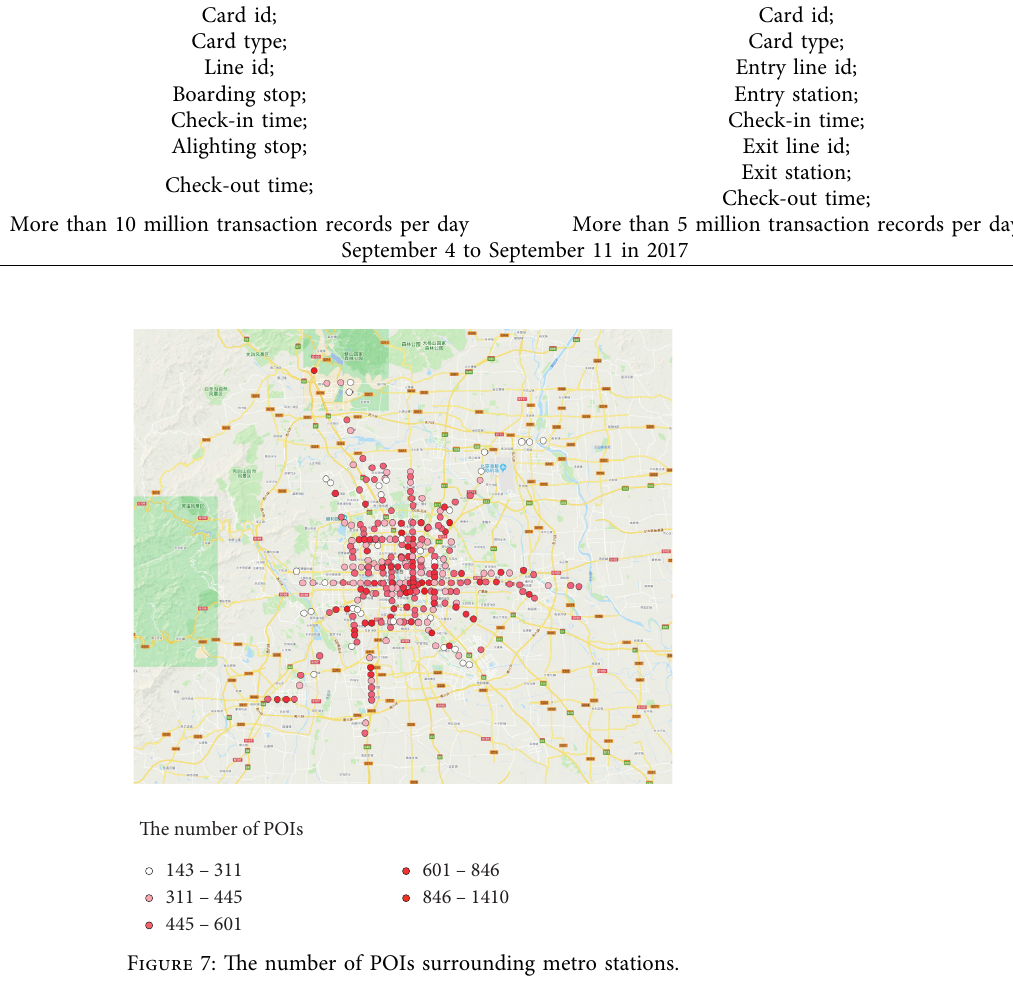
Table 2: Information on smart card data used in this paper. Data concept